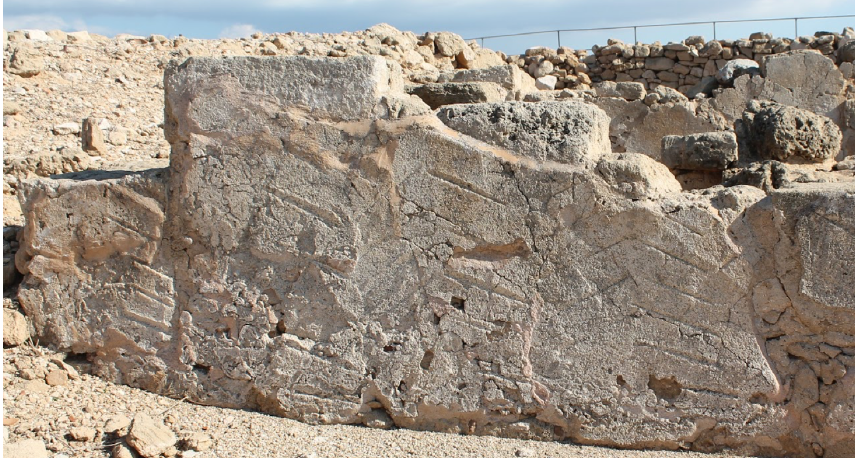
Figure 8. Herringbone incisions in the arriccio layer (base plaster layer) as preparation for subsequent plaster layers, from the House of